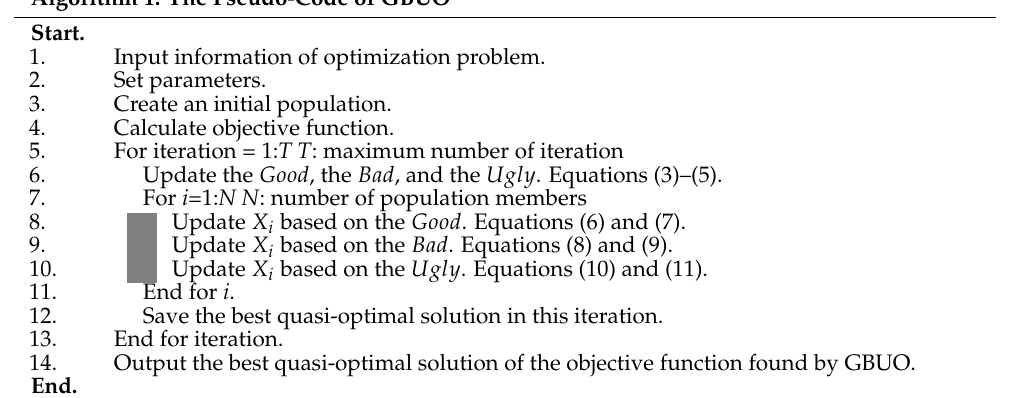
Algorithm 1. The Pseudo-Code of